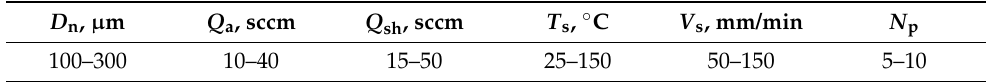
Table 1. Investigated parameters of aerosol jet printing (AJP) during the formation of Pt microstructures. D n , µ m Q a ,